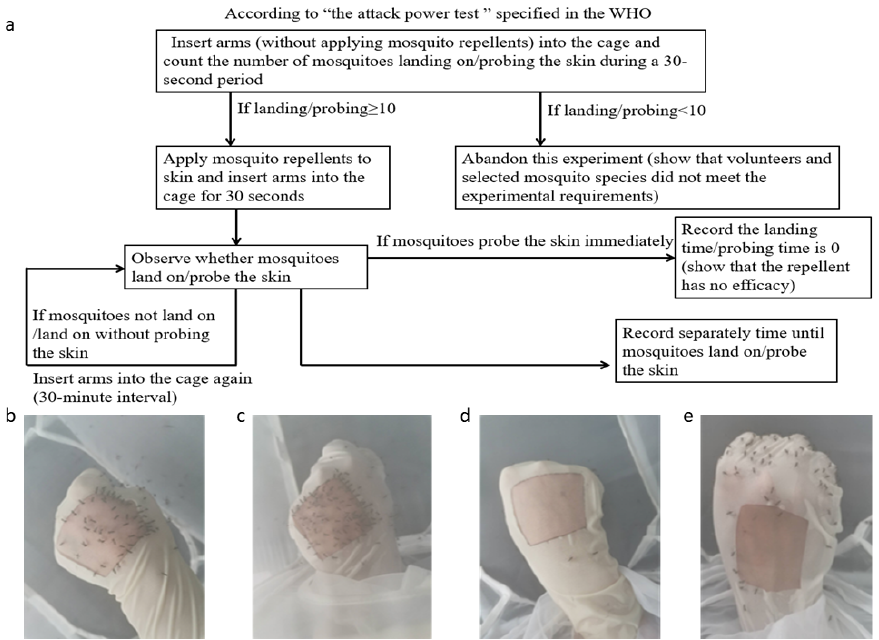
Figure 3. A mosquito attack power testing: ( a ) pre-experiment design; ( b / c ) more than 10 mosquitoes landed/probed; ( d / e ) less than 10 mosquitoes landed/probed. Only if the biting rate was ≥ 10 land- ings and/or probings in 30 s, the mosquitoes and volunteers were qualified for further testing.